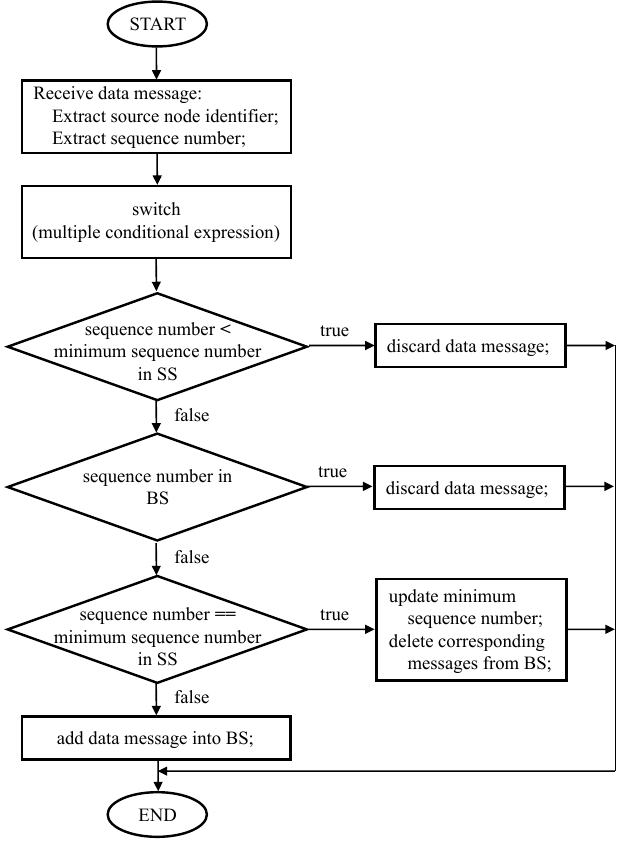
Figure 1. An information flow of a normal node that receives a data message. Here, SS and BS denote Seed Set and Buffered Message Set,